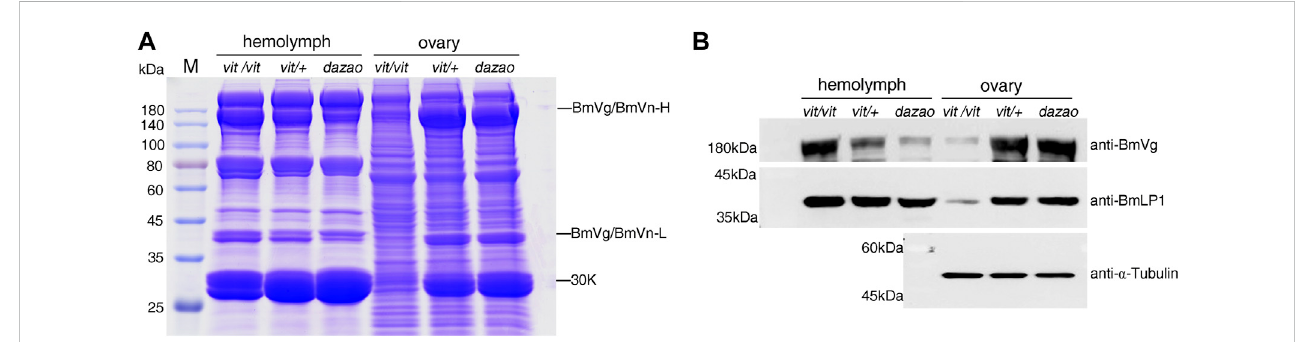
FIGURE 6 Detection of BmLP1 and BmVg/BmVn in BmVgR mutant hemolymph and ovaries. (A) Detection of total proteins from silkworm hemolymph and ovaries of the vit mutant , vit/+ , and the dazao strains on day fi ve of pupation by SDS-PAGE (25 μ g/lane). (B) Detection of the BmVg/BmVn and BmLP1 proteins in the hemolymph and ovaries of vit mutant , vit/+ , and dazao by western blotting (30 μ g/lane) on day fi ve of pupation. Vit/+ and dazao were used as controls. Anti- BmVg and anti-BmLP1 rabbit antibodies and HRP-conjugated goat anti-rabbit IgG (H + L) antibody were used at a dilution of 1:10,000.